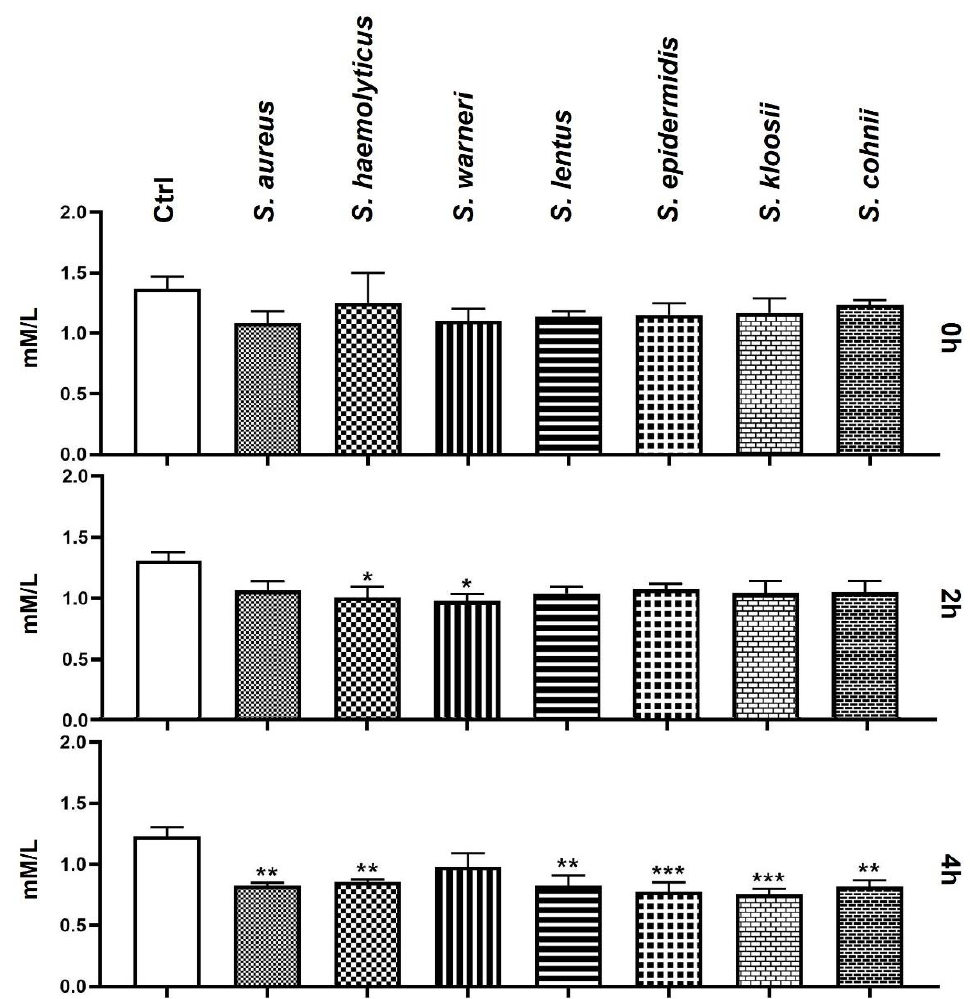
Figure 7. Changes in concentration of extracellular Ca during the 4 h bacteria/sperm co-incubation in vitro at 37 °C. Each group treated with Staphylococcus species was compared with the Ctrl group with no added bacteria. Each bar represents the mean concentration of extracellular Ca ± S.E.M. Five individual experiments were performed to obtain these data. The level of statistical significance was set at * p < 0.05; ** p < 0.01; *** p < 0.001.